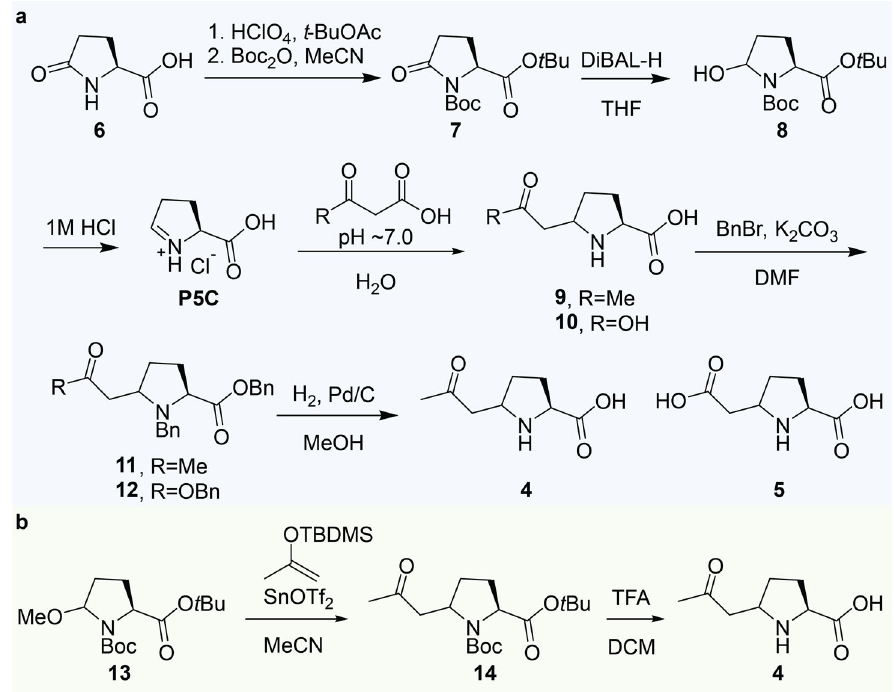
Fig. 4 Synthesis of the standards used for the con fi rmation of the biomarkers. Biomarkers 4-5 were synthesized via ( a ) an incubation of malonic acid or acetoacetic acid with P5C and b the mixture of diasteroeisomers of 4 was synthesized via N-acyliminium ion